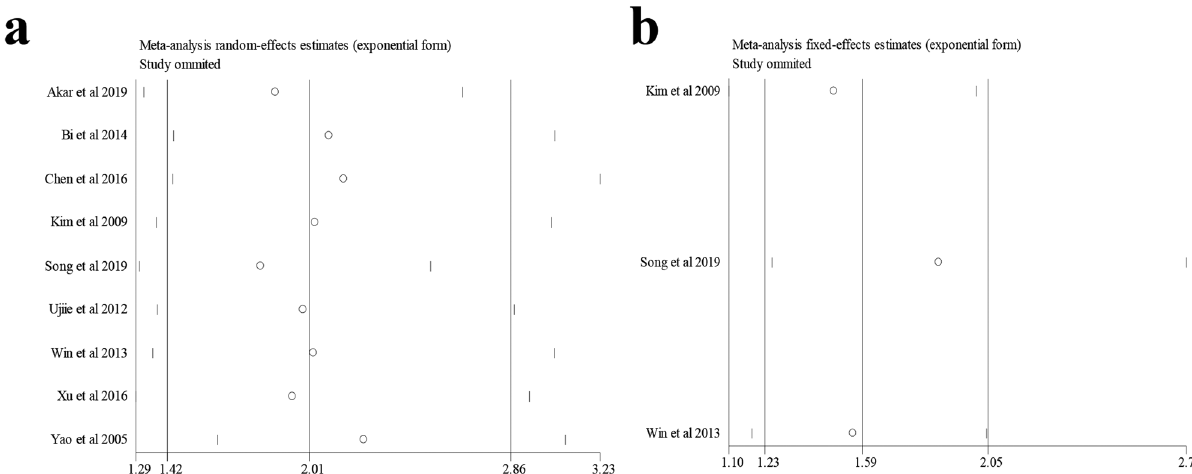
Figure 6: Sensitivity analysis indicated that the meta - analysis results for OS and DFS were reliable: ( a ) OS and ( b ) DFS.